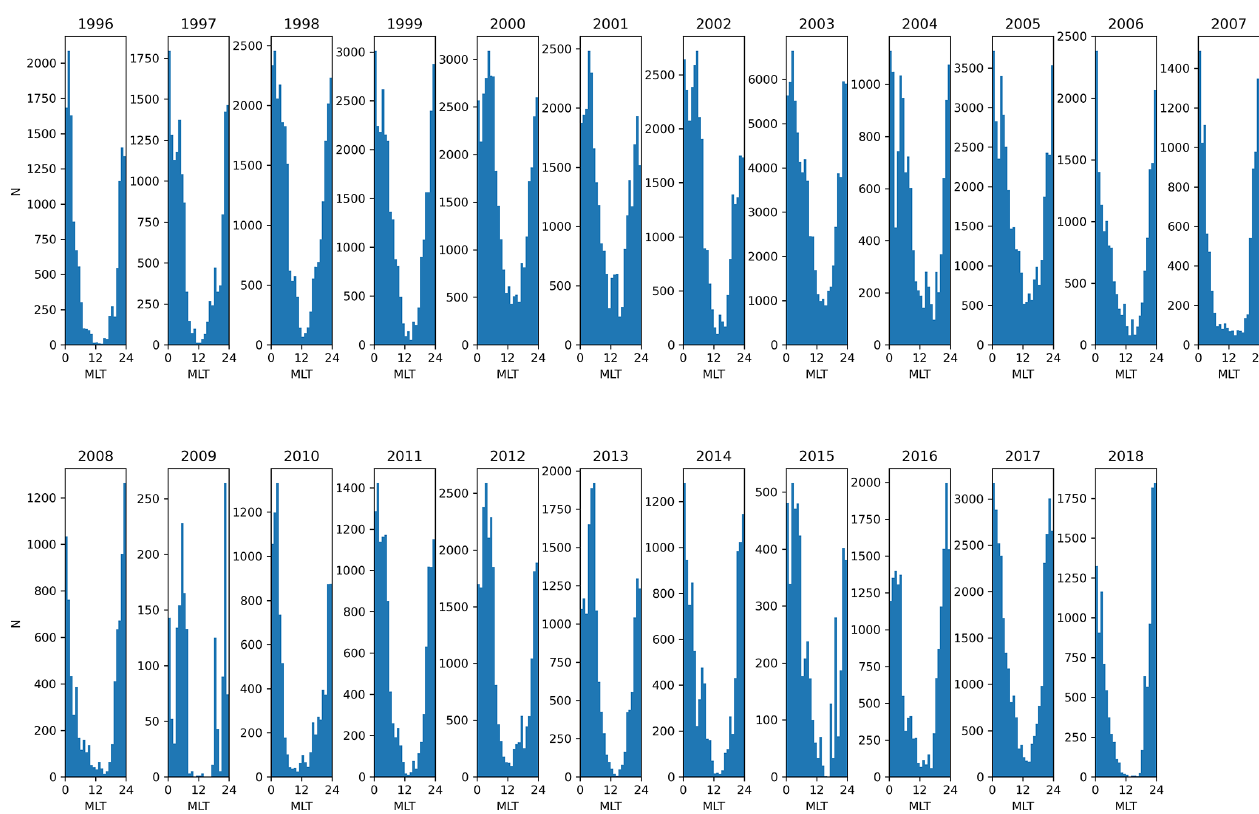
Figure 9. MLT distribution of the number of events ( N ) fitting the | d (cid:49) H / d t | > 1nTs − 1 criterion. Sodankylä (SOD), 1996–2018.